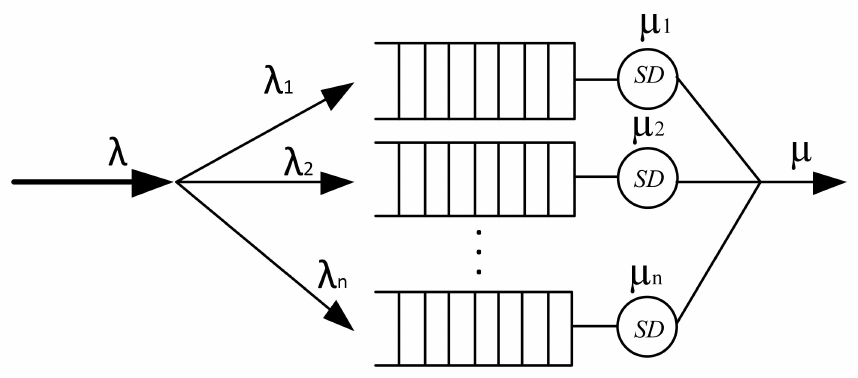
Figure 4. Model of a multiple virtual routers.